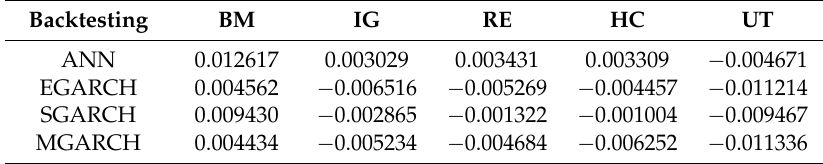
Table A2. Average difference between in sample prediction and out of sample returns.